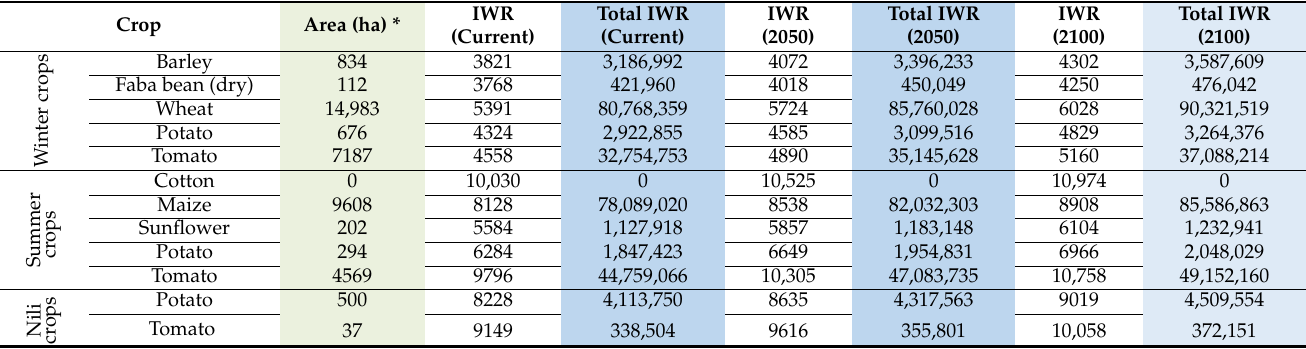
Table 2. Total irrigation water requirements (IWR, m 3 ) for some main crops in the new lands of Middle Egypt under current and climate change